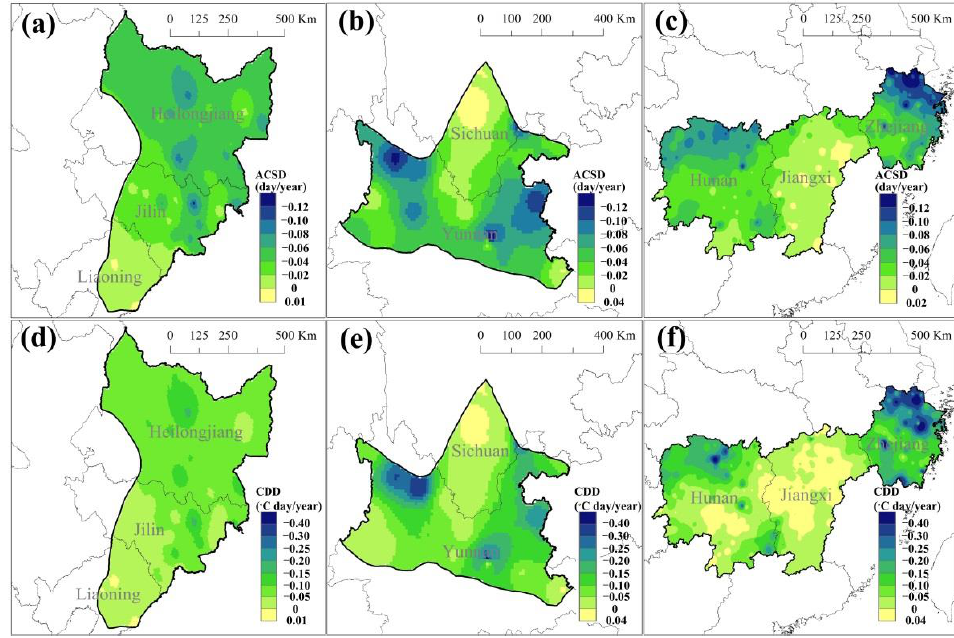
Figure 3. Temporal trends of cold stress indices during heading and flowering during 1960 – 2019: ( a , d ) single rice in NEP; ( b , e ) single rice in YNP; ( c , f ) late rice in SMLYR. ACSD, accumulated cold stress days; CDD, cold degree days.